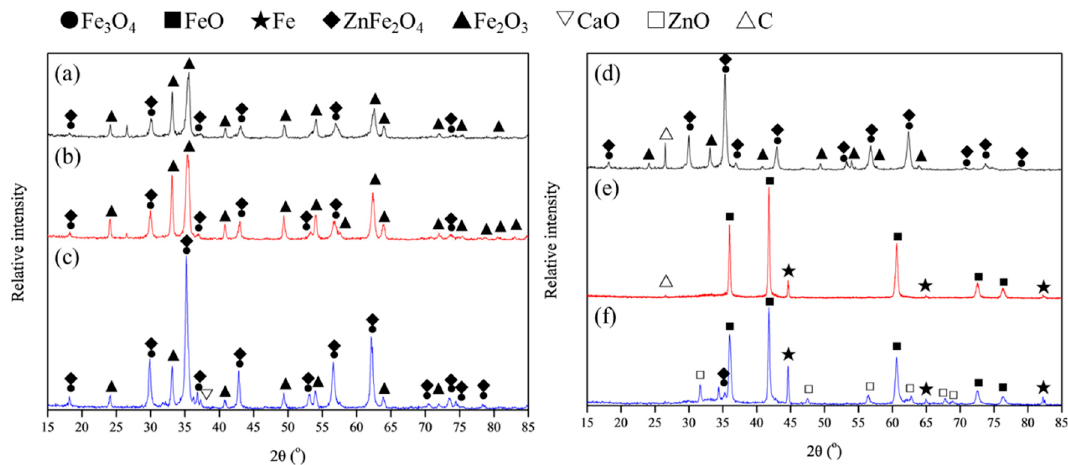
Figure 4. The XRD patterns of the BOS filter cakes subjected to TG-DSC analysis in air and argon atmospheres: ( a ) BOS-1, in air; ( b ) BOS-2, in air; ( c ) BOS-3, in air; ( d ) BOS-1, in argon; ( e ) BOS-2, in argon; ( f ) BOS-3, in argon.